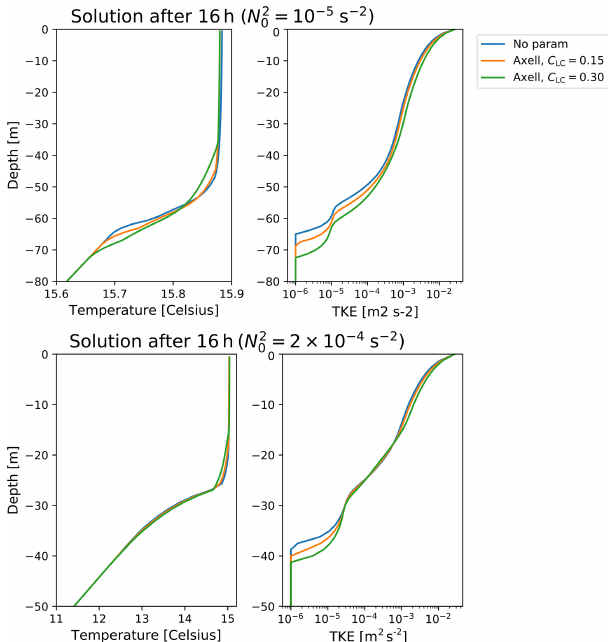
Figure B1. Solution obtained for the Noh et al. (2016) single- column experiment after 16h for different parameter values in the Axell (2002) Langmuir cell parameterization in the case N 2